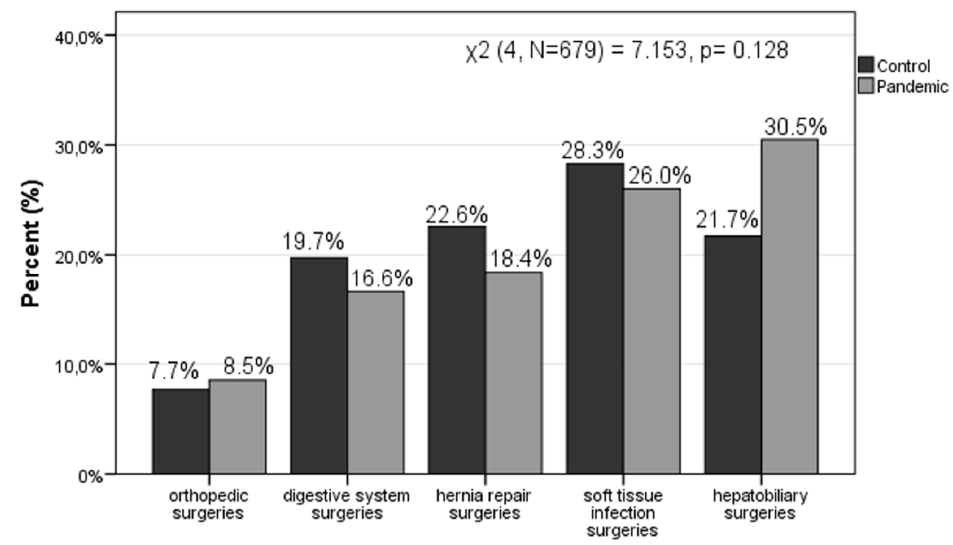
Figure 2. Bar ‐ chart comparing the types of surgeries during the control and pandemic periods. Figure 2. Bar-chart comparing the types of surgeries during the control and pandemic